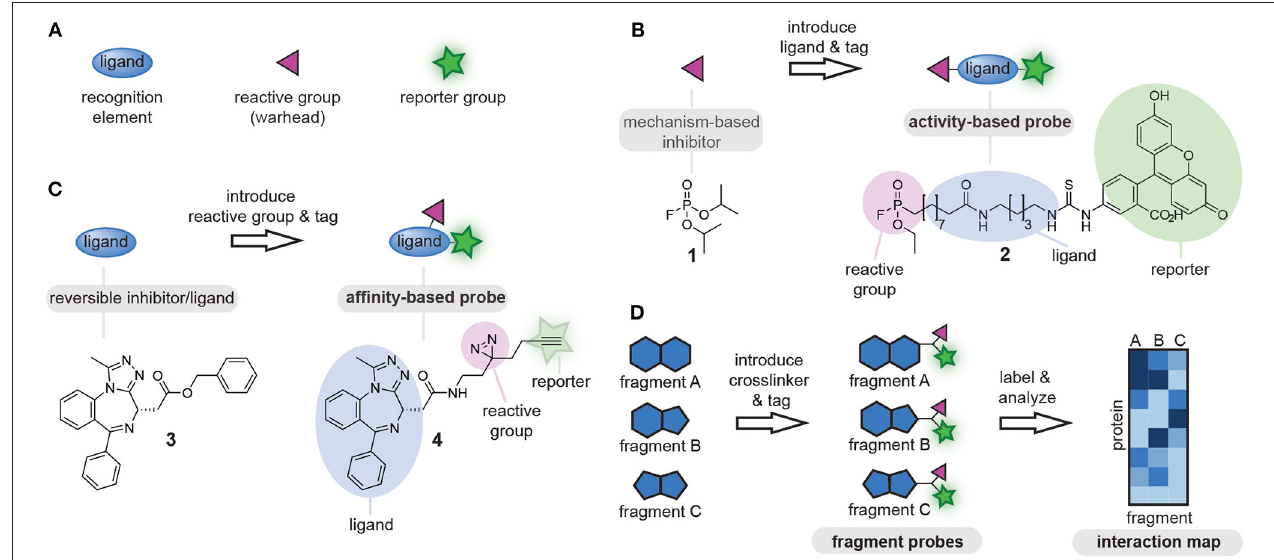
FIGURE 1 | (A) Schematic representations of the components of chemical probes. (B) Schematic representation of activity-based chemical probe design. The reactive group is leading in the design and commonly reactive groups that exploit the mechanism of the target enzyme are used as starting point. (C) Schematic representation of affinity-based chemical probe design. The ligand is leading in the design of affinity-based probes and often known bioactive molecules are used as starting point. (D) Schematic representation of a chemoproteomic fragment library. Small molecular fragments (ligands) are equipped with the identical reactive groups and reporter groups and are screened against complex protein mixtures using chemoproteomic approaches. To visualize the differences between the fragments, the proteins that bind to different fragments are plotted in an interaction map. The color correlates with the enrichment fold. Dark colored proteins are enriched the most. The resulting selectivity profiles enable the identification of new probe-protein